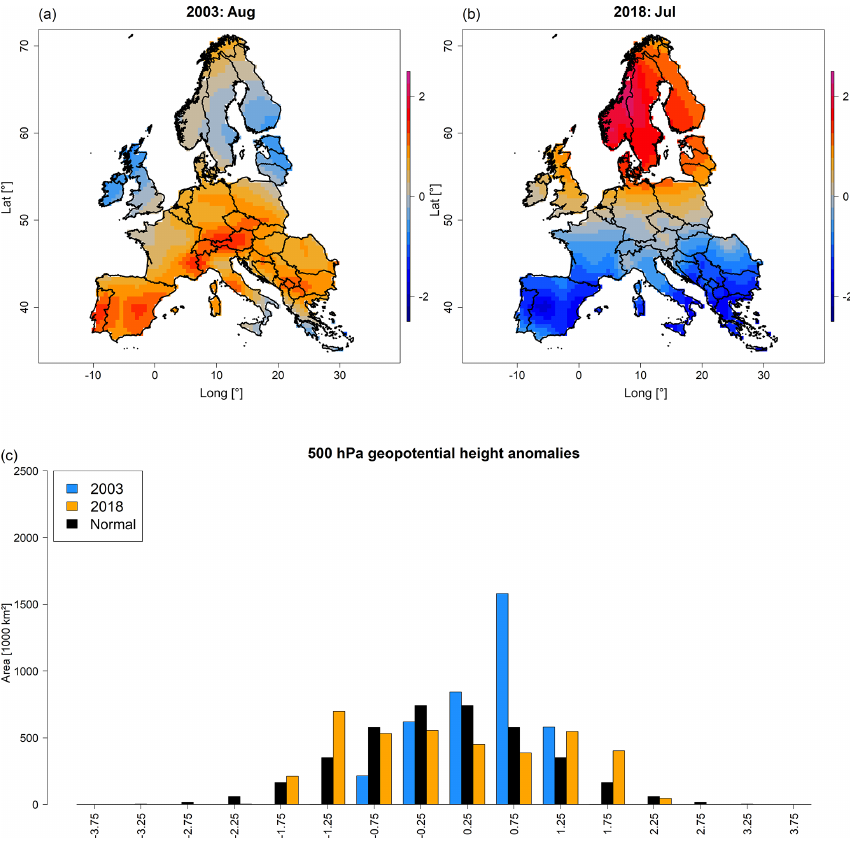
Figure 1. Maps depicting standardized anomalies of 500hPa geopotential height for August 2003 and July 2018 (a, b) as well as corre- sponding area histograms (in units of thousands of square kilometres) for 2003 (blue) and 2018 (orange) compared to a normal distribution (black) (c) . Shades of blue in (a) and (b) indicate geopotential height that is lower than average, whereas shades of red indicate above-average geopotential height in comparison to the 1981–2018